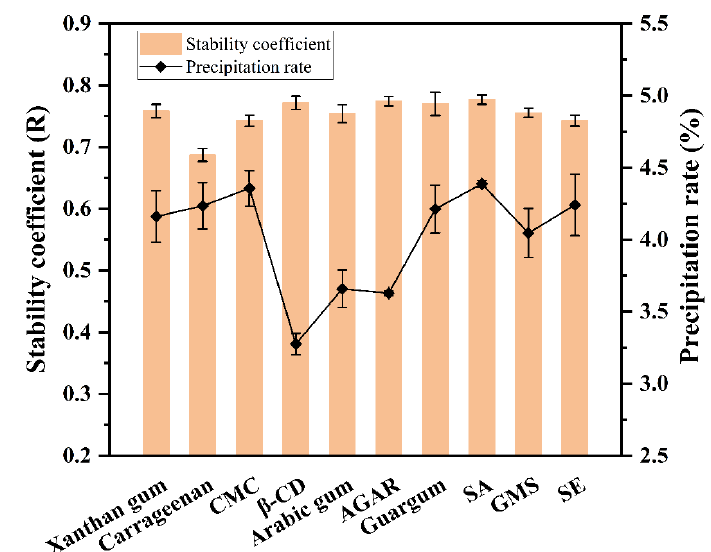
Figure 2. Optimal single ‐ factor comparison of stabilizers.